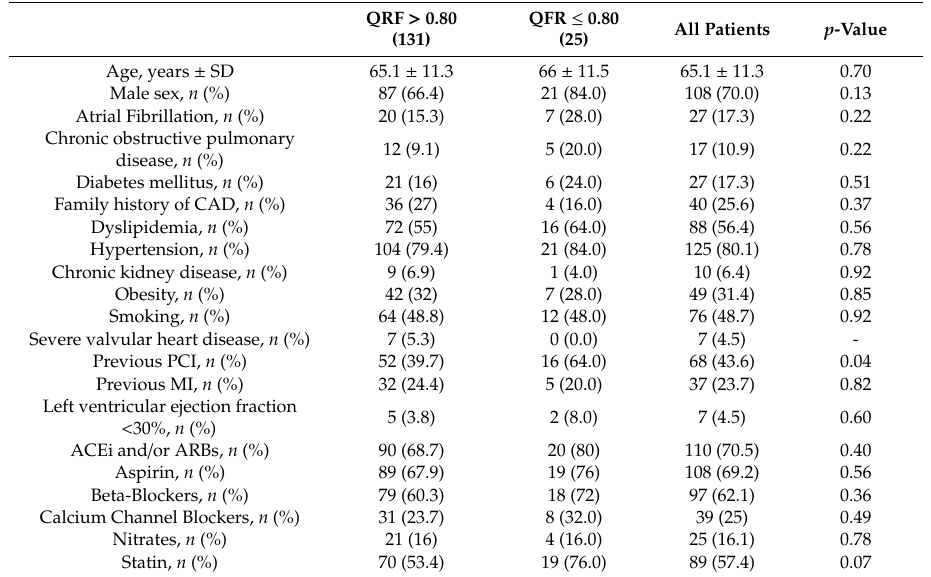
CAD: coronary artery disease. ACEi: angiotensin-converting enzyme inhibitors; ARB: angiotensin receptor blockers. Chronic kidney disease: GFR < 60 mL / min. CABG: coronary by-pass. MI: myocardial infarction; PCI: percutaneous coronary intervention. SD: Standard